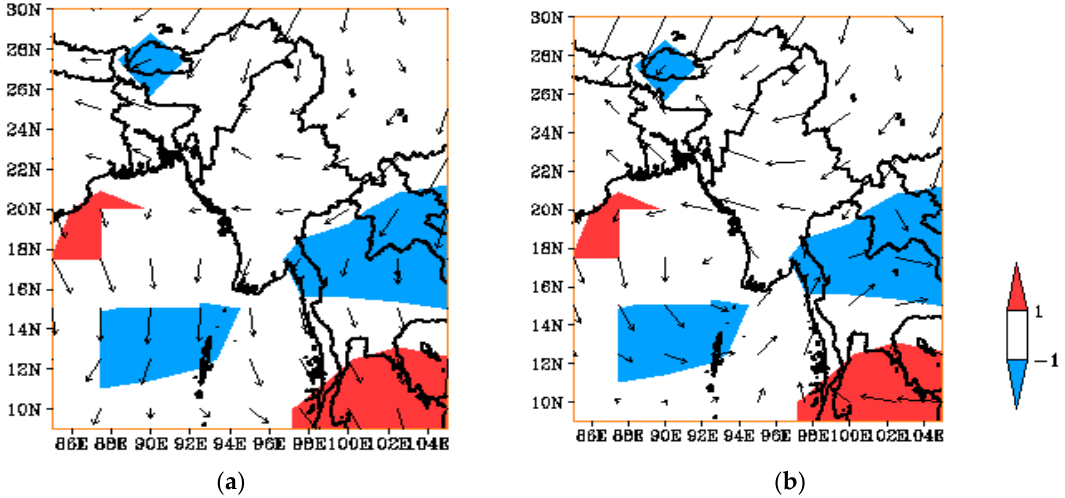
Figure 11. Winter (November–February) wind anomaly at 850 hPa for ( a ) warm years and ( b ) cold years in the study region.